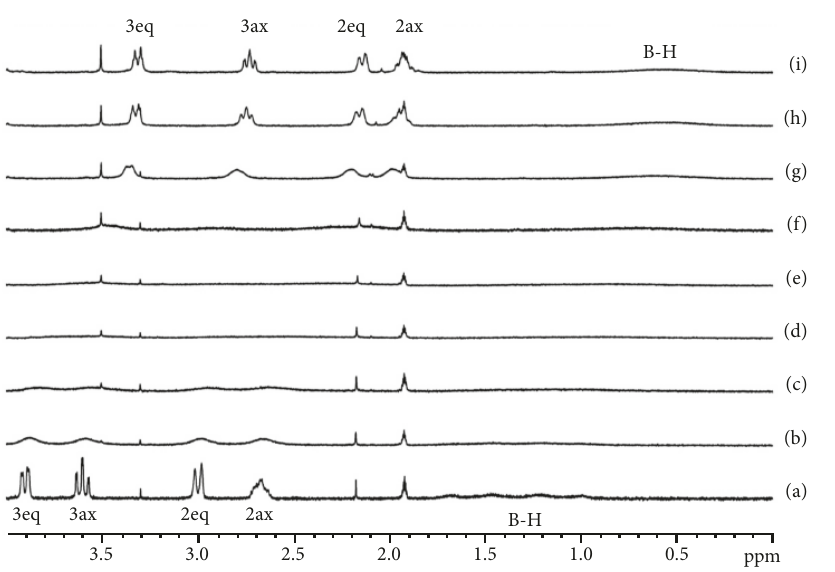
Figure 4: 1 H NMR titration of morpholine borane (1.0 mM) with (a) 0.00, (b) 0.16, (c) 0.30, (d) 0.44, (e) 0.62, (f) 0.83, (g) 1.17, (h) 2.24, and